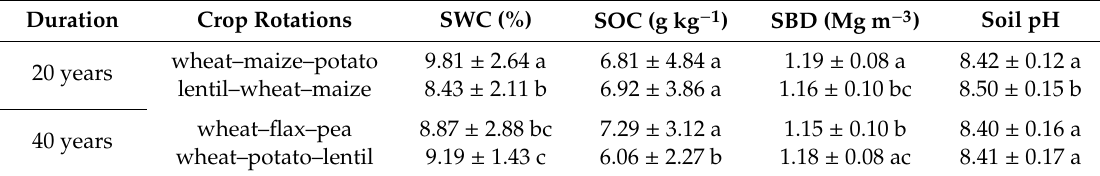
Table 1. The soil water content (SWC), soil organic carbon (SOC), soil water content (SWC), soil bulk density (SBD) and soil pH of di ff erent crop rotation patterns (mean ± standard